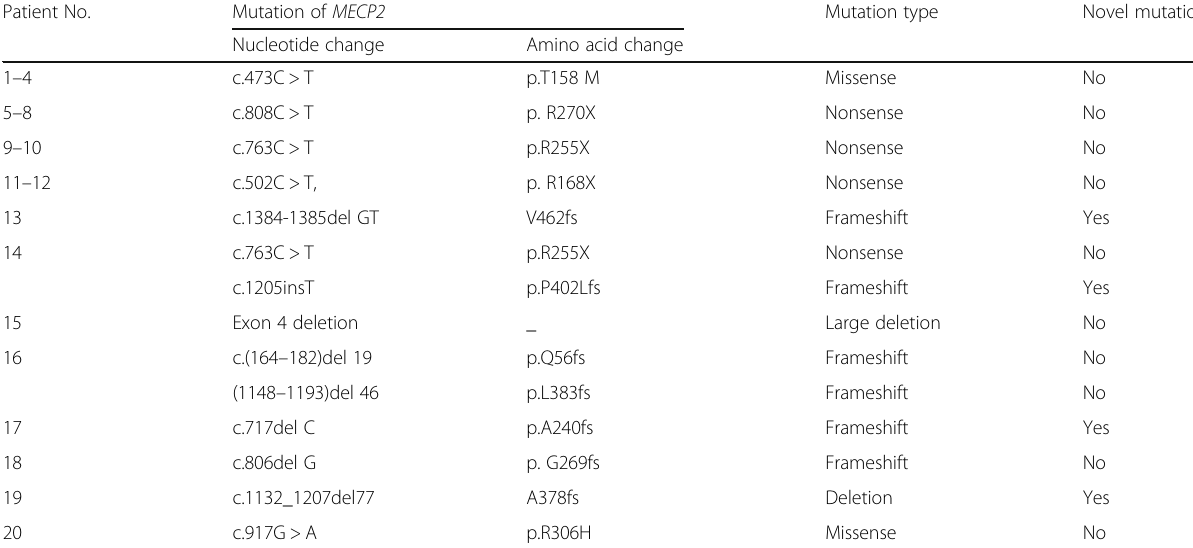
Table 2 Mutation alleles frequency of RETT patients Patient No.